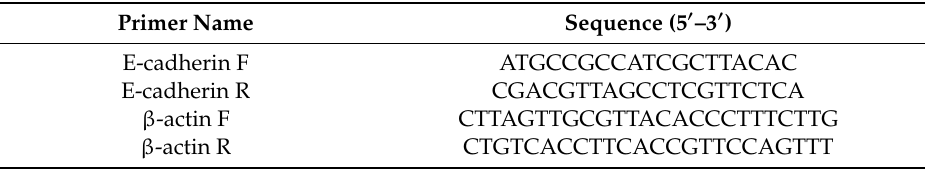
Table 2. Sequences of the primers for real-time